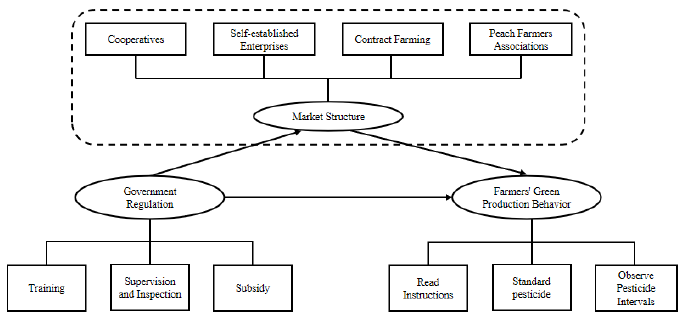
Figure 1. Logical Figure 1. Logical framework.